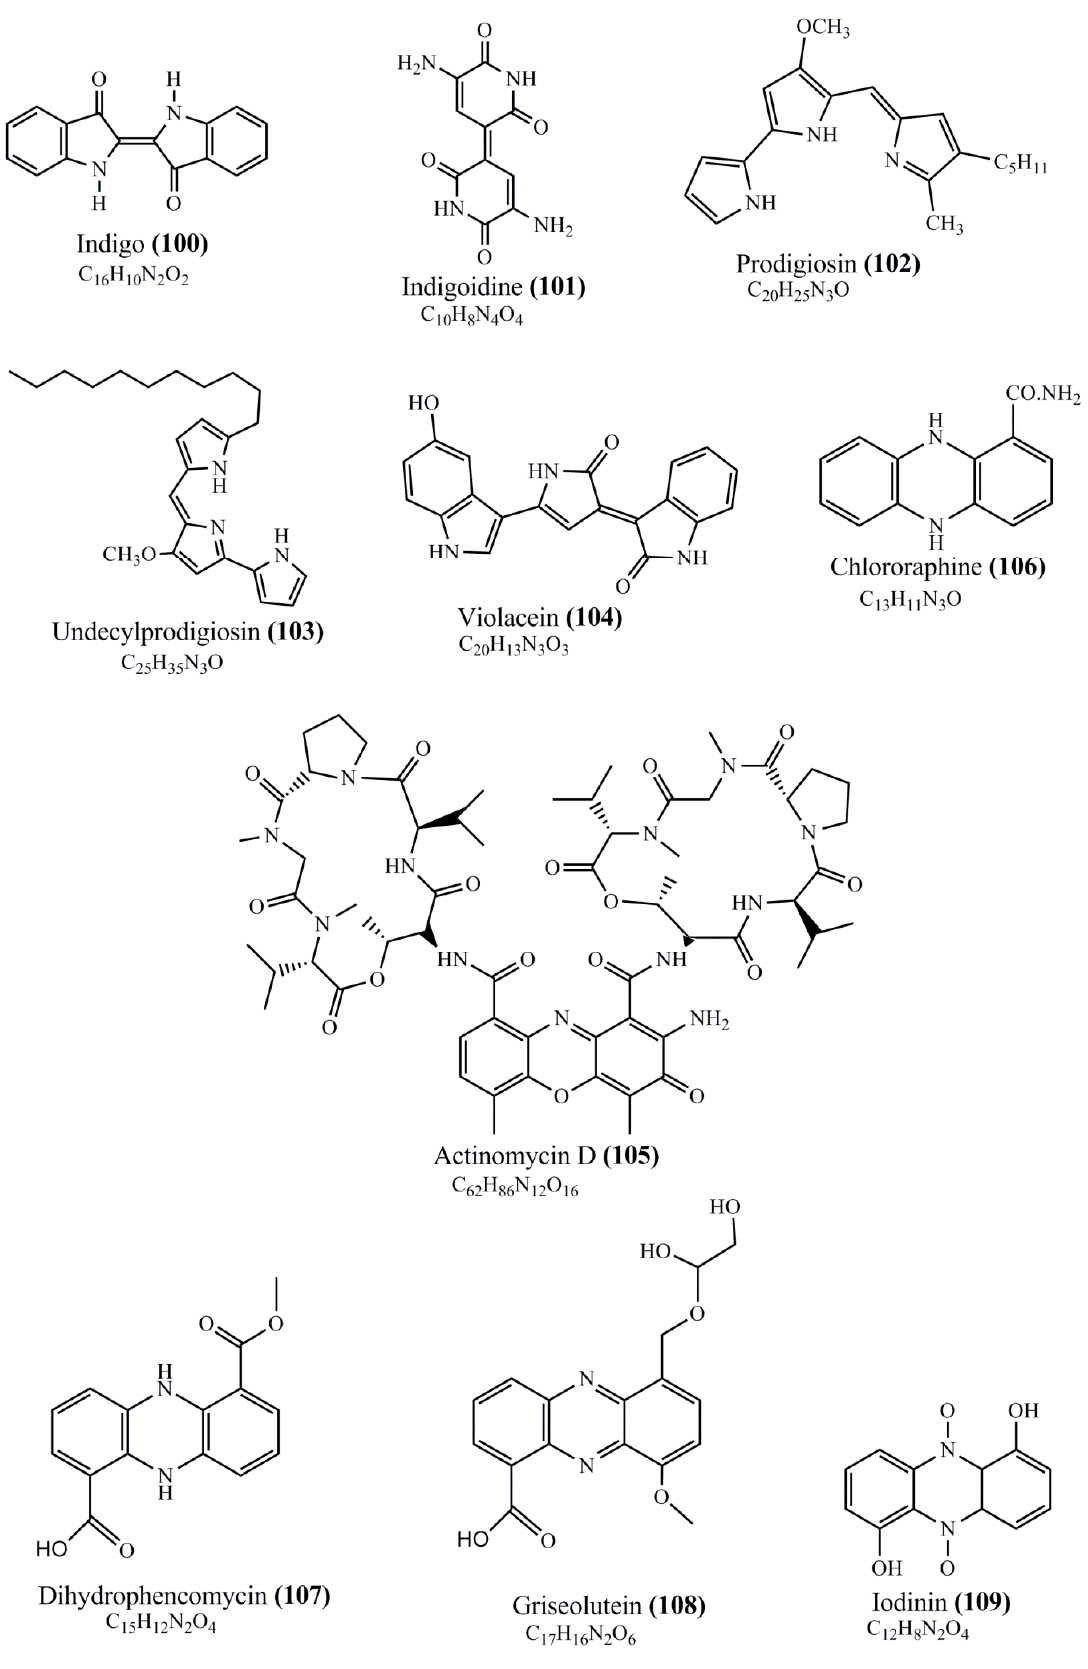
Figure 1. Figure 1. Continued.